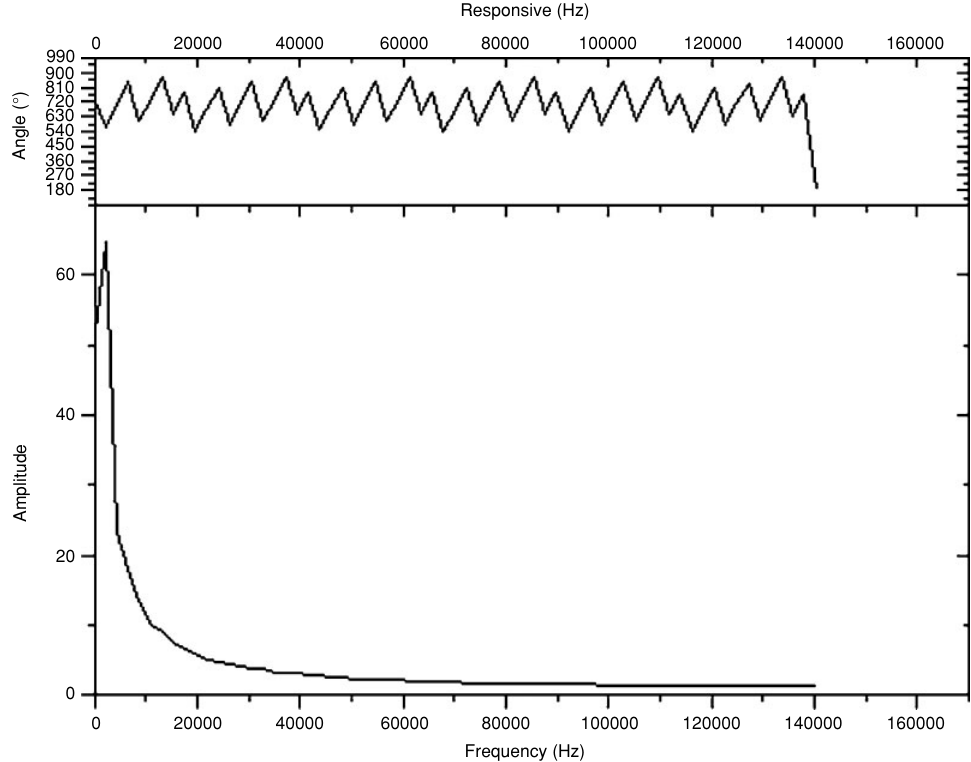
Figure 6 Response of the blood through Fast Fourier Transform analysis.